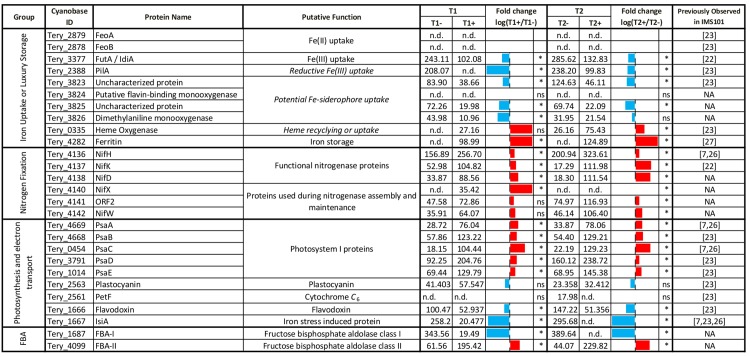
Observed abundance and fold change of selected proteins.All the specifically mentioned proteins alongside their abundances (fmol μg-1). Fold changes are shown as sparklines (blue = more abundant during Fe-deplete conditions, red = more abundant during Fe-replete conditions) and statistical significance of change is denoted with an asterisk. The reporting in previous studies is listed in the final column.